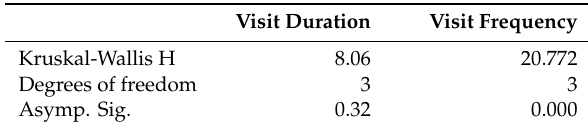
Table 1. The dependence of the frequency and duration of forest visits on the proximity of a forest to a kindergarten.